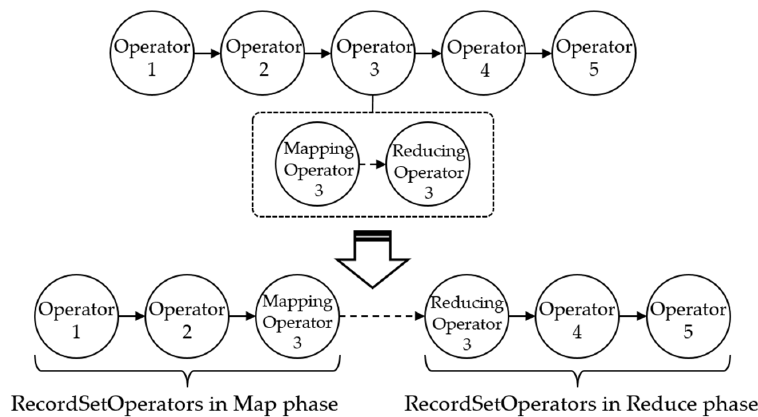
Figure 8. An example of transforming a Plan to a sequence of MapReduce jobs in Marmot.